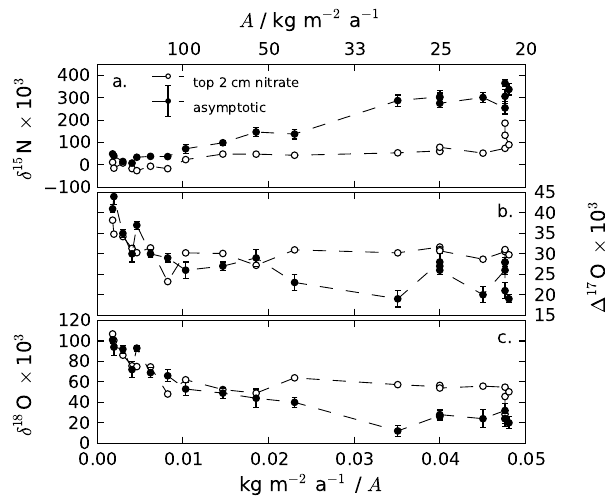
Fig. 8. Asymptotic nitrate isotopic composition and the isotopic composition of nitrate in the top 2cm of snow in East